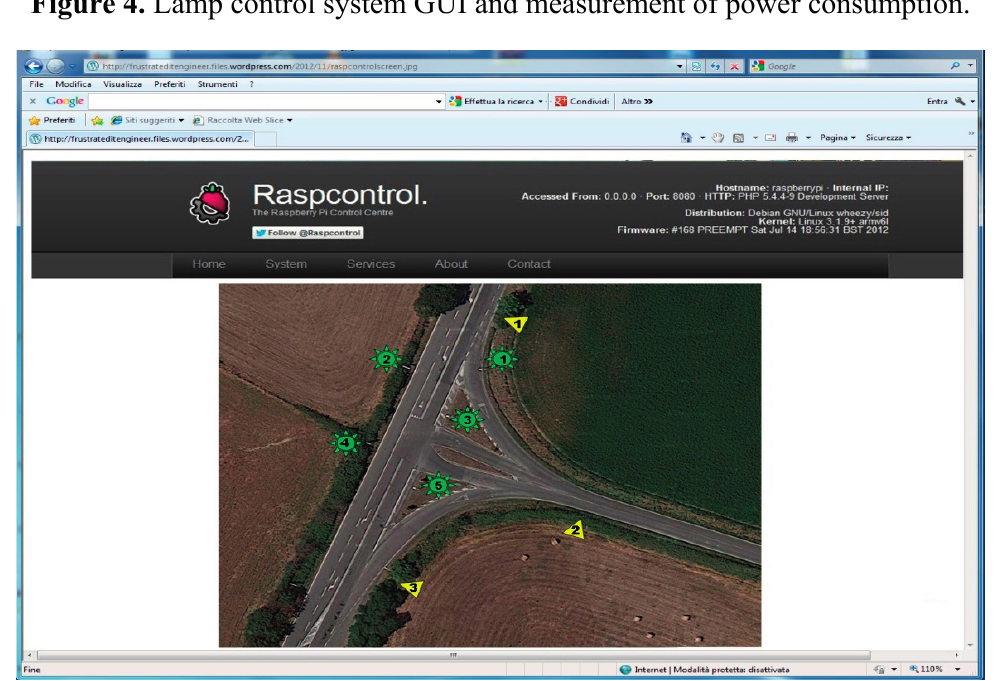
Figure 4. Lamp control system GUI and measurement of power